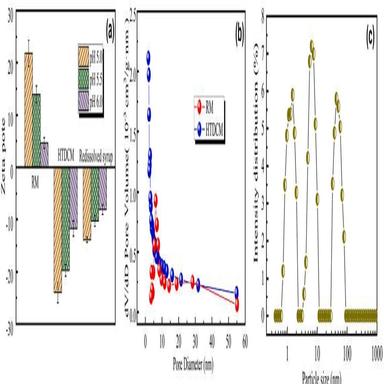
(a) Zeta potentials of RM, HTDCM, and redissolved syrup at different pH values. (b) Pore size distributions of RM and HTDCM. (c) Particle size distribution of the brown sugar redissolved syrup. (For interpretation of the references to colour in this figure legend, the reader is referred to the Web version of this article.)